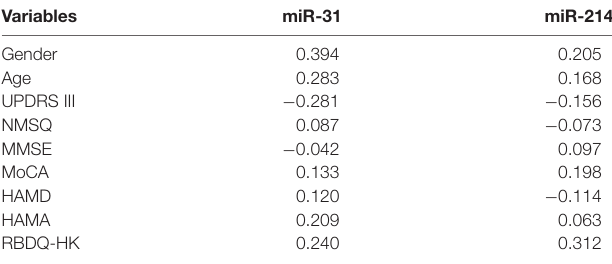
TABLE 3 | Associations between serum miRNAs and clinical characteristics in pPD patients by Spearman’s rank correlation analysis.